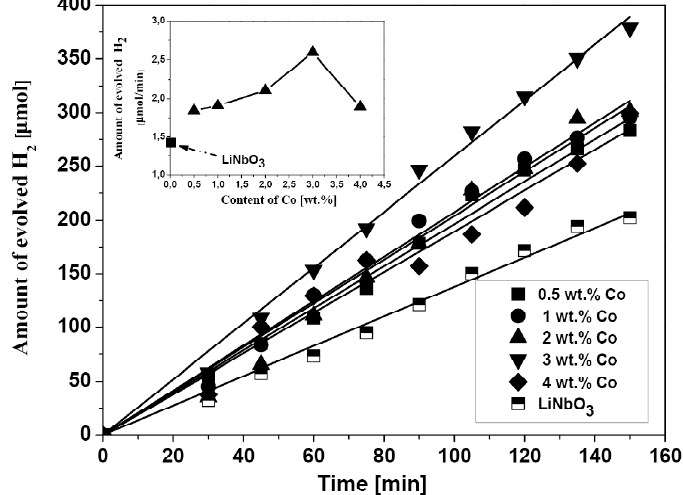
Figure 5. Photocatalytic H